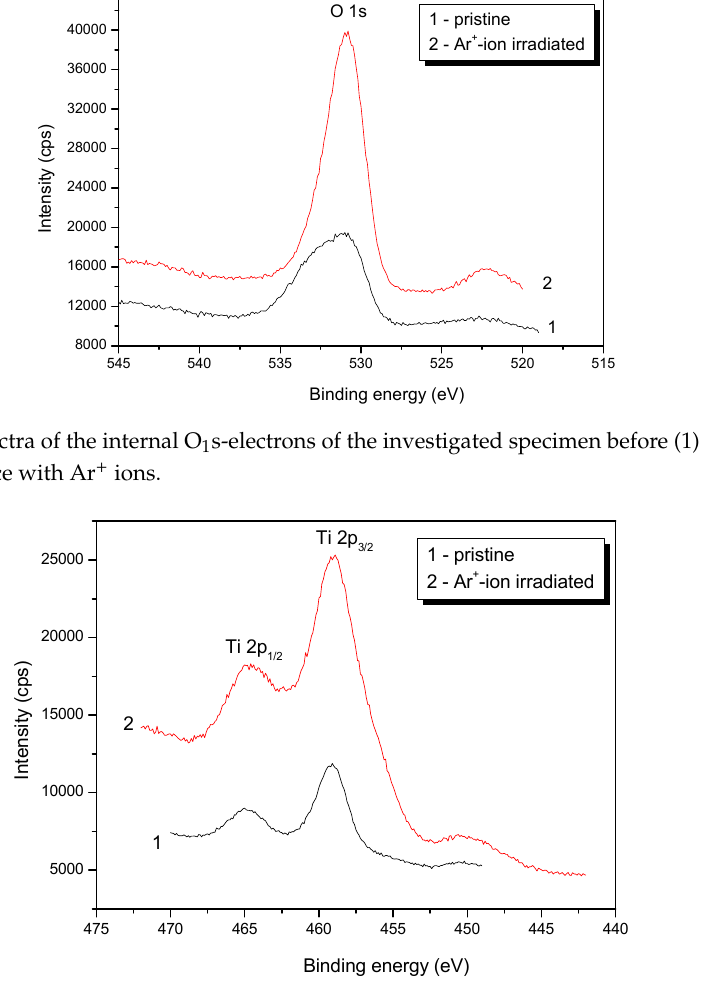
Figure 8. XPS spectra of internal Ti 2 p electrons of the investigated specimen before (1) and after (2) cleaning its surface with Ar + ions.